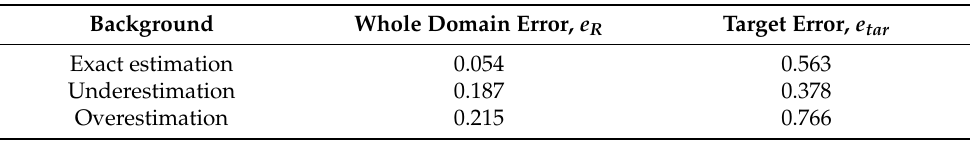
Figure 13. Reconstructed distribution of the real part of the dielectric permittivity, Re { ε r } , in the investigation domain R together with a square box indicating the shape of the actual target. Back- ground dielectric permittivity in the inversion procedure: ( a ) underestimation ( 𝜀 𝑟,𝑏∗ = 𝜀 𝑟,𝑏 − 0.5) and ( b ) overestimation ( 𝜀 𝑟,𝑏∗ = 𝜀 𝑟,𝑏 + 0.5 ).